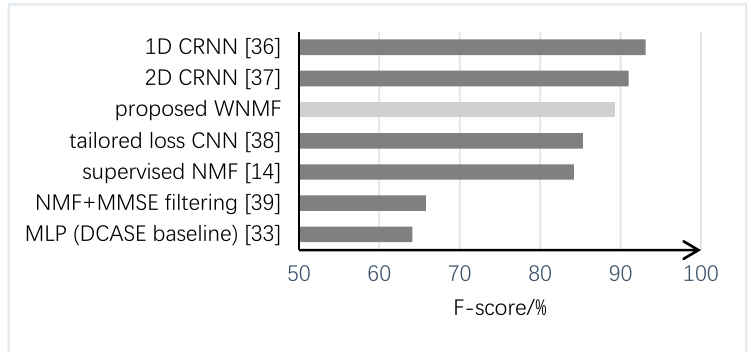
Figure 7. Performance comparison of the proposed method with some other methods submitted to Task 2 of the Detection and Classification of Acoustic Scenes and Events 2017 Workshop (DCASE 2017) challenge.